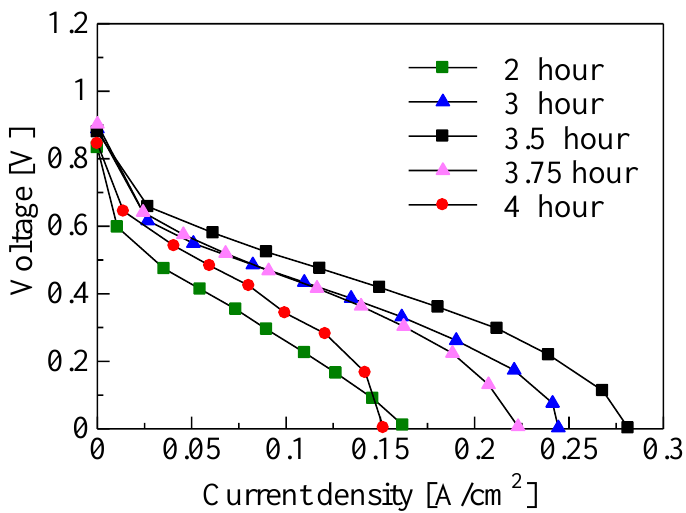
Figure 5. Voltage–current density (V–J) curve of single PEFC cells of Pt/CNW/MPL/CP for various Figure 5. Voltage – current density (V – J) curve of single PEFC cells of Pt/CNW/MPL/CP for various growth times of the CNWs. growth times of the CNWs.